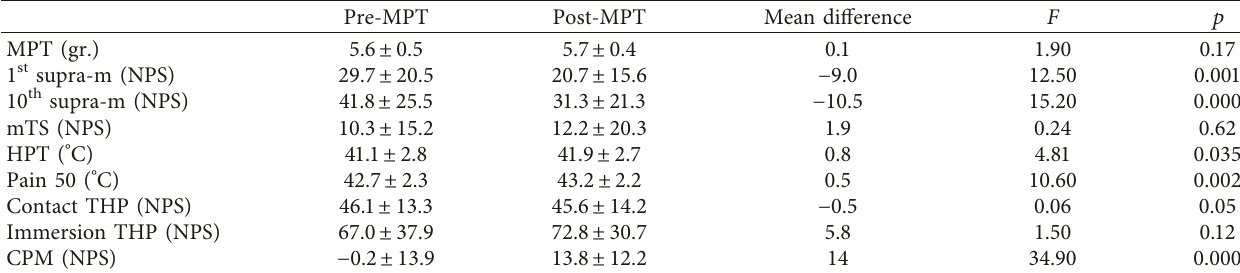
Table 1: Differences in experimental pain parameters before and after MPT.